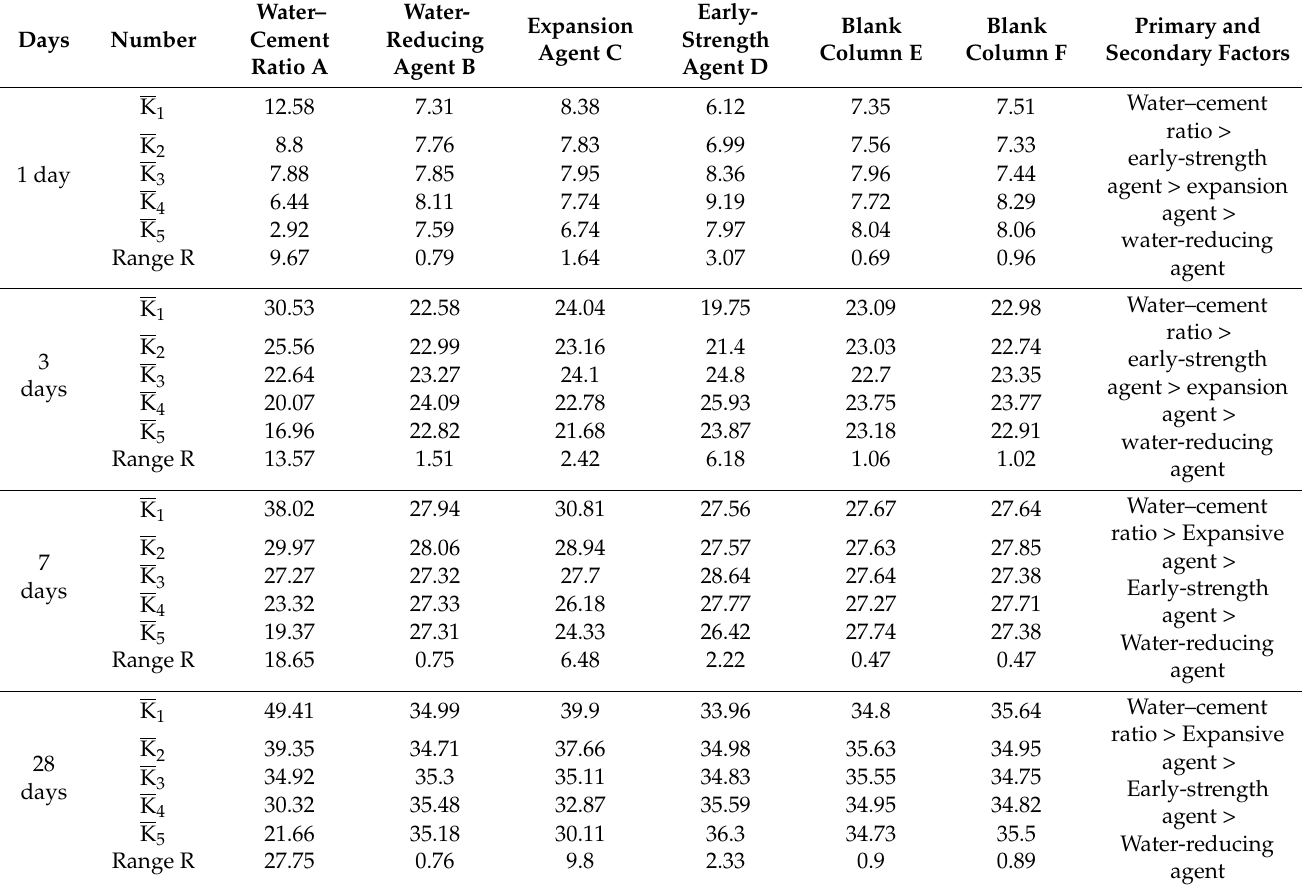
Table 3. Range analysis of orthogonal test results for compressive strength